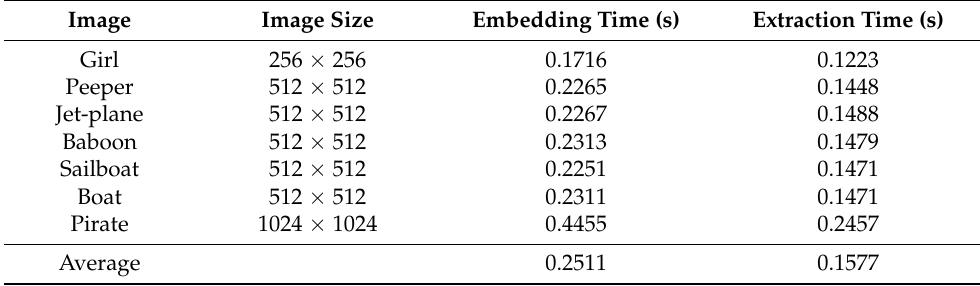
Table 2. Execution time for watermark embedding and extraction